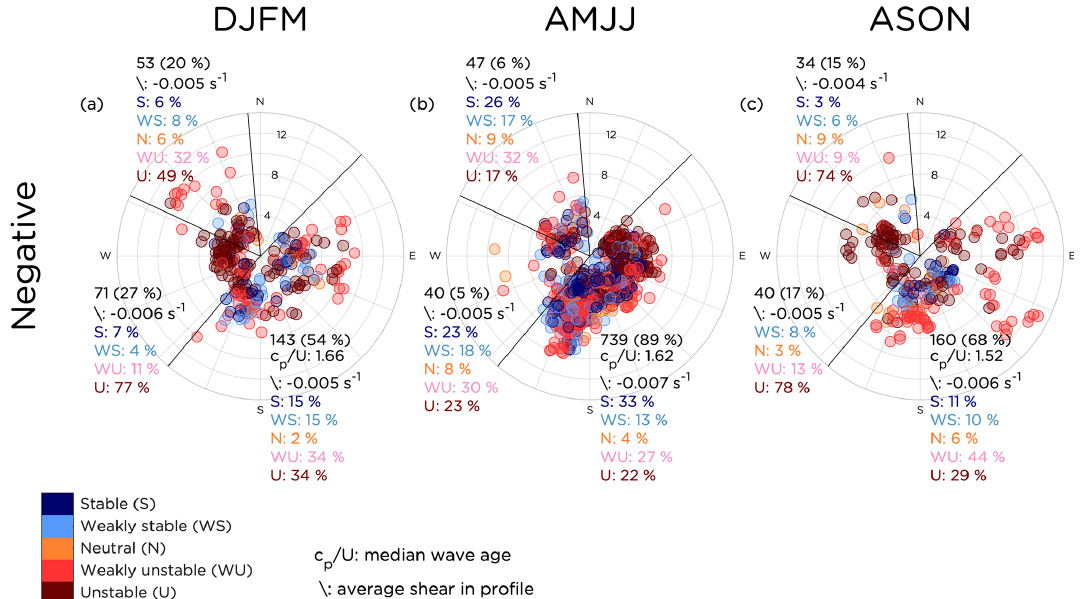
Figure 7. Overview of the seasonal occurrence for all profiles classified as negative profiles, presented in the same manner as in Fig. 6 with (a) corresponding to DJFM, (b) corresponding to AMJJ and (c) corresponding to ASON. Larger versions of the panels can be found in Figs. S12–S14 in the Supplement.